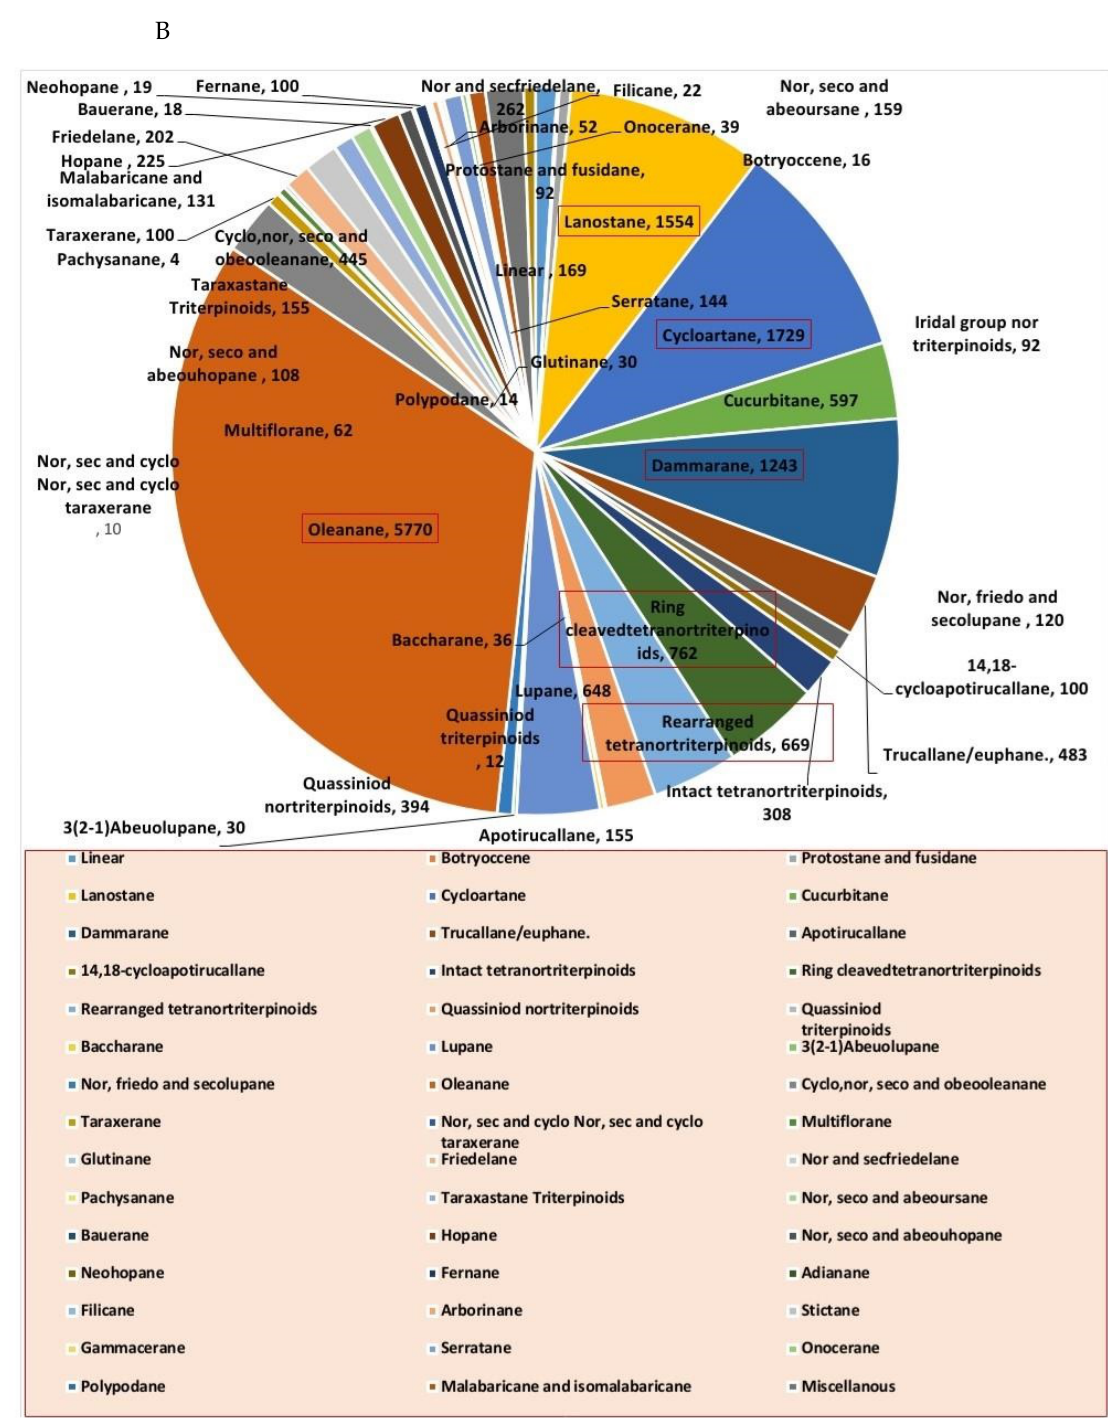
Figure 1. Pie charts indicating the distribution of chemical subclasses of steroids ( A ) and triterpenes ( B ). Many representatives from both classes (i.e., steroids and triterpenoids) have been reported for a wide spectrum of pharmacological activity (e.g., antimicrobial, anticancer, and anti-inflammatory activities) (Figure 2). Our current review aims to shed light on the antiviral potential of these interesting secondary metabolites classes (i.e., steroids and triterpenes) illustrating their mode of actions either directly (i.e., direct viral inhibition) or indirectly (i.e., boosting the host immune response, reducing the inflammatory and antago- nize some host-based molecular targets used by viruses for cell entry and multiplica- tion). We also investigated the probability of these reviewed triterpenes and sterols to